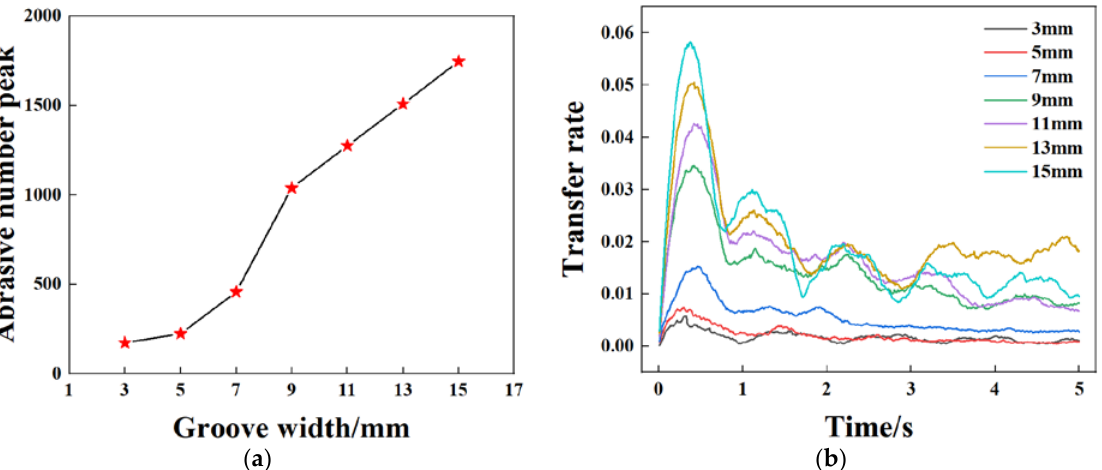
Figure 7. Abrasive transfer rate curves with different retaining ring groove widths. ( a ) Abrasive number peak as a function of groove width, ( b ) abrasive transfer rate under different groove width.